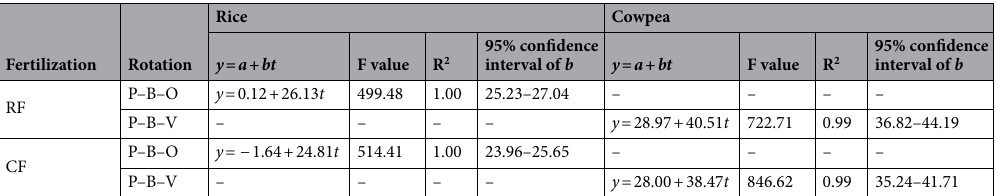
Table 8. Linear grey model of yield trends of rice and cowpea for different